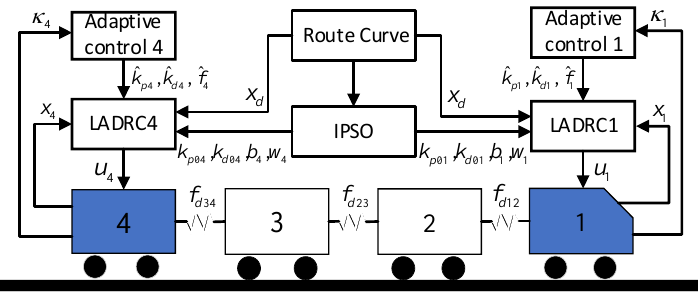
Figure 1. Control scheme structure diagram.